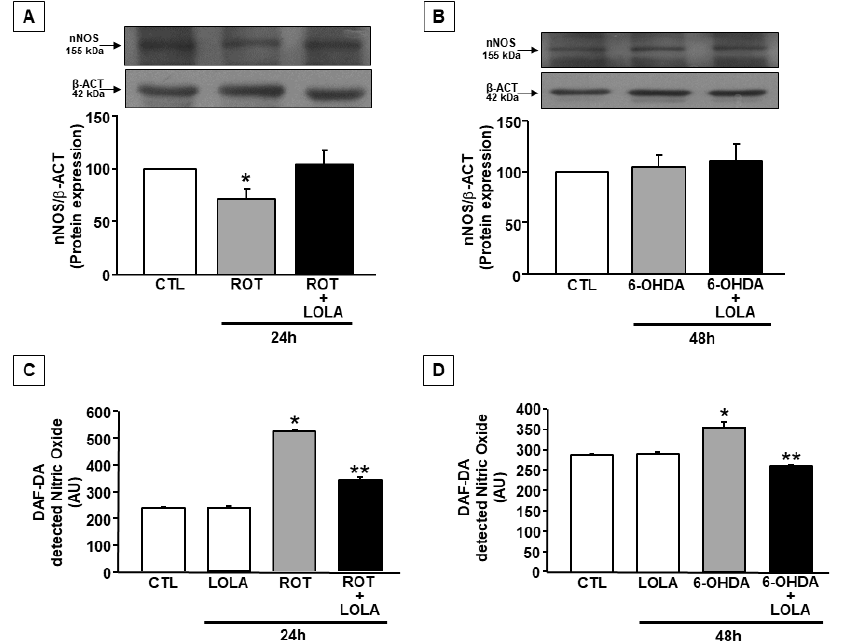
Figure 4. nNOS expression and NO production in SH-SY5Y cells exposed to ROT and 6-OHDA and treated with LOLA: ( A ) nNOS expression in cells treated with ROT (500 nM/24 h) and ROT +LOLA (5 mM/24 h) and ( B ) with 6-OHDA (30 µ M/48 h) and 6-OHDA+LOLA; * p < 0.05 vs. CTL. ( C ) NO production in cells treated with LOLA, ROT, and ROT+LOLA; * p < 0.05 vs. CTL; ** p < 0.05 vs. ROT and CTL. ( D ) NO production in cells treated with LOLA, 6-OHDA, and 6-OHDA +LOLA; * p < 0.05 vs. CTL; ** p < 0.05 vs. 6-OHDA. The values are expressed as arbitrary units measured on 4 different experiments. In panels ( A , B ), each column represents the mean of percentage ± SEM; in panels ( C , D ), each column represents the mean ± SEM.